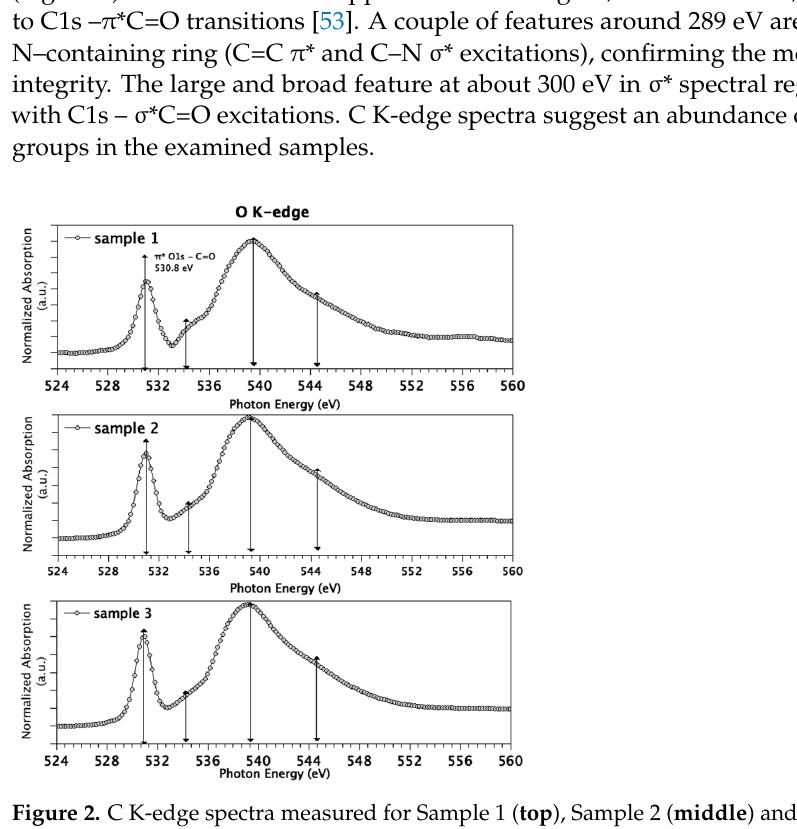
Figure 3. O K-edge spectra measured for Sample 1 ( top ), Sample 2 ( middle ) and Sample 3 ( bot- tom ). Since in NEXAFS data analysis the so-called building block approach can be success- fully applied [55] (i.e., the NEXAFS spectrum of a complex molecule or sample can be built by summing up the contribution arising by the different functional groups, weighted for their abundance in the sample), the presence of strong features diagnostic for carbonyl groups, and only weak contributions arising by hydroxyls, suggests that the polymer is mainly in the oxidized state. The PDA content in the PDAx@CeO 2 composite samples was determined by thermo- gravimetric analysis. The weight loss curves for Samples 1, 2 and 3, as well as for bare CeO 2 , are displayed in Figure 4. While CeO 2 does not present any appreciable loss, the